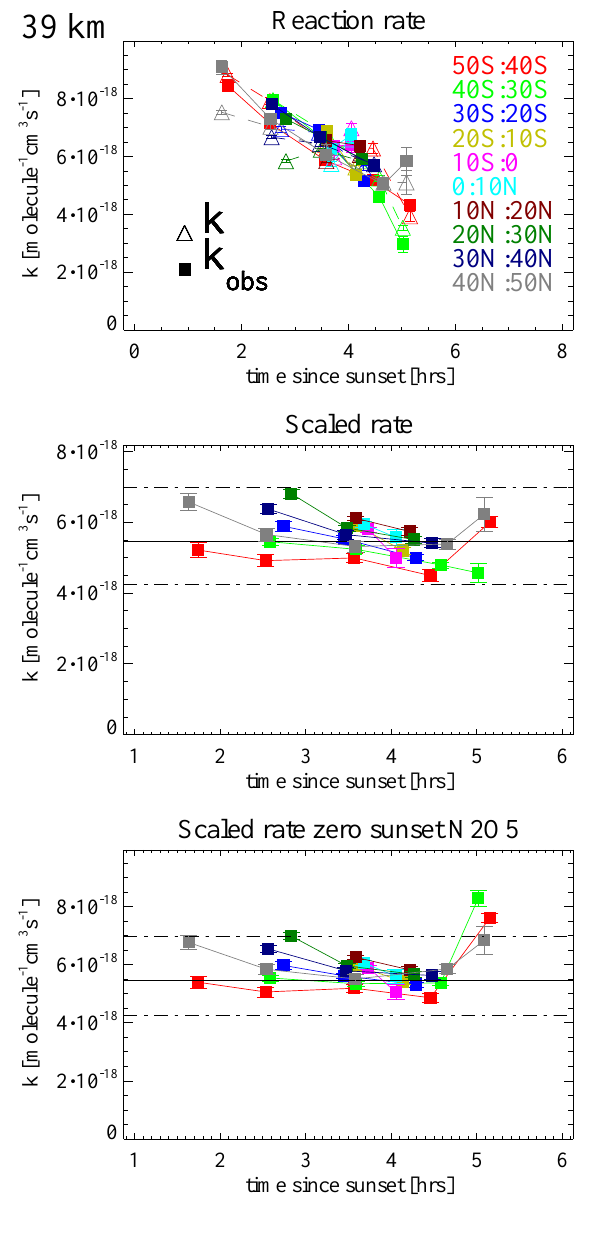
50 Fig. 12. As in Fig. 10 but at